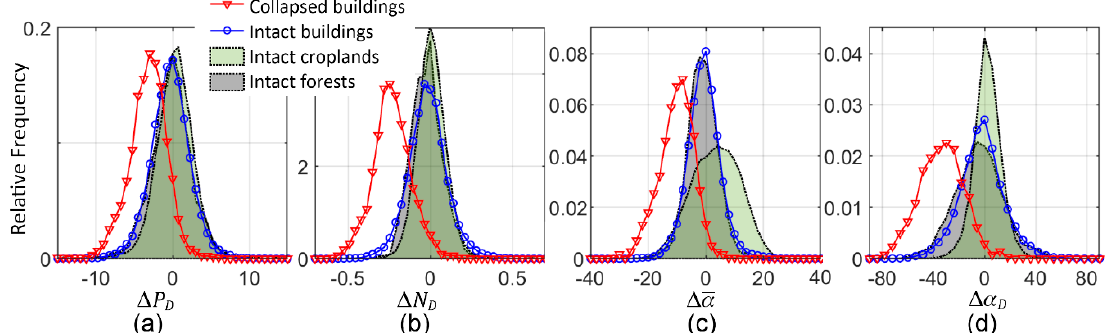
Figure 7. Histograms of the scattering mechanism indicators: ( a ) the double-bounce scattering power ( ∆ P D ), ( b ) the double-bounce scattering contribution among total received signals ( ∆ N D ), ( c ) the mean scattering mechanism ( ∆ α ), and ( d ) the change of the dominant scattering mechanism ( ∆ α D